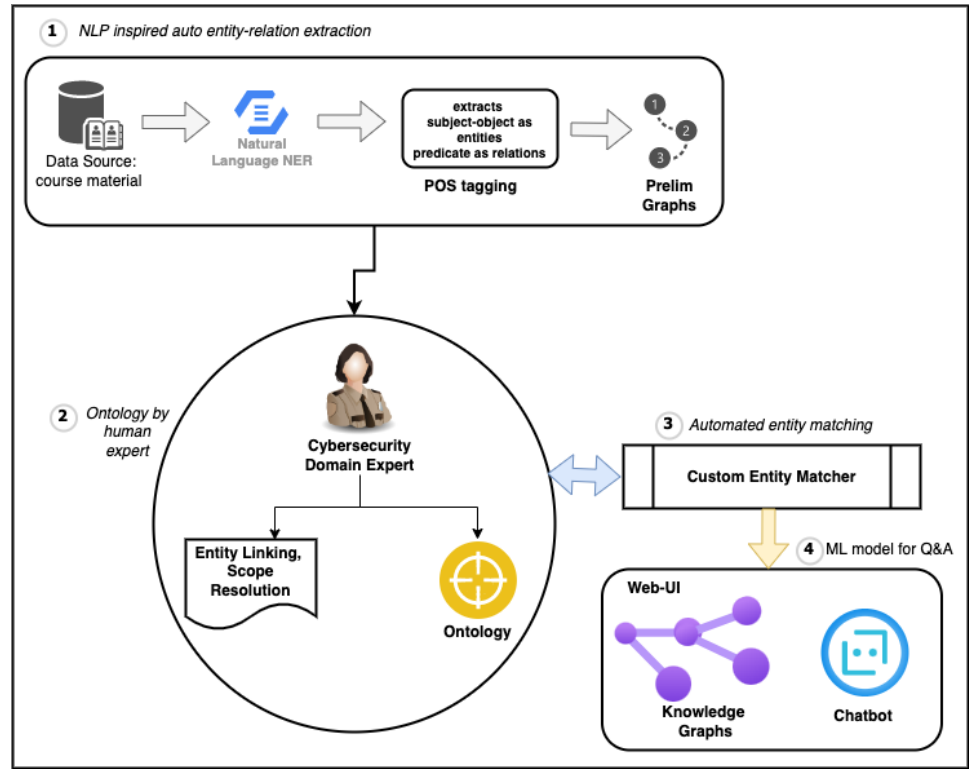
Figure 8. The pipeline of our framework as illustrated in Section 3. Step (1) shows the knowledge acquisition and automated entity extraction using NER, as given in Section 3.1.2. Step (2) shows the knowledge integration and ontology development by the human domain expert, as explained in Sections 3.1.3 and 3.1.4. The key entities and relations identified in (2) are given to custom entity matcher in Step (3), as explained in Section 3.1.5. The resulting triples are used in Step (4) to view the knowledge graphs and build other downstream tasks such as question answering, as shown in Section